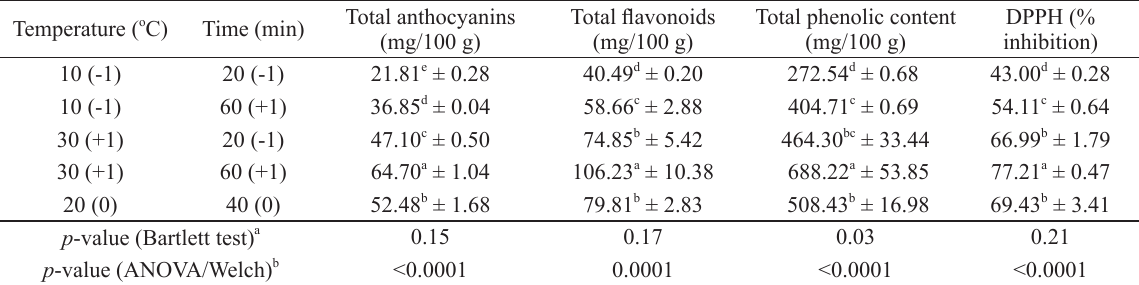
Total phenolic content, flavonoids, anthocyanins and in vitro antioxidant capacity of Ocimum basilicum L. leaf extracts obtained with different temperature and extraction